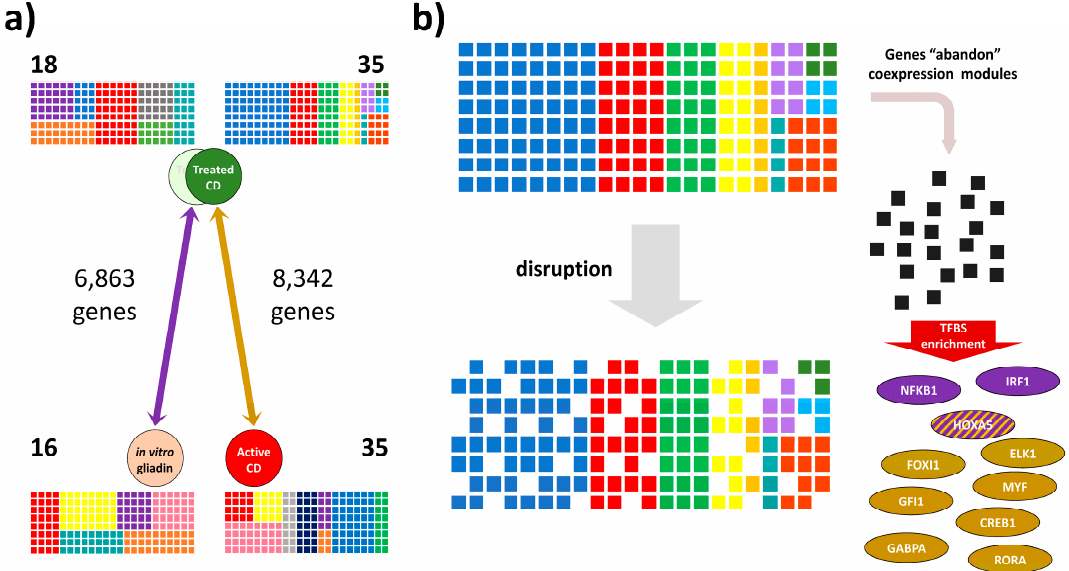
Figure 1. Co-expressed gene modules and differentially co-expressed genes in response to gliadin; ( a ) Representation of co-expression modules of acute (purple arrow) and chronic (golden arrow) response to gliadin. Each square represents a gene, while genes forming a co-expression module share a color. The number of genes used for the construction of modules is indicated for each experiment, and the numbers in bold represent the amount of modules identified in each experiment and condition; ( b ) Representation of differentially co-expressed genes (DCGs; black squares) and enrichment analysis for transcription factor binding sites (TFBS). Three transcription factors (TFs) were identified in the acute experiment (purple) and 8 TFs in the chronic experiment (gold).